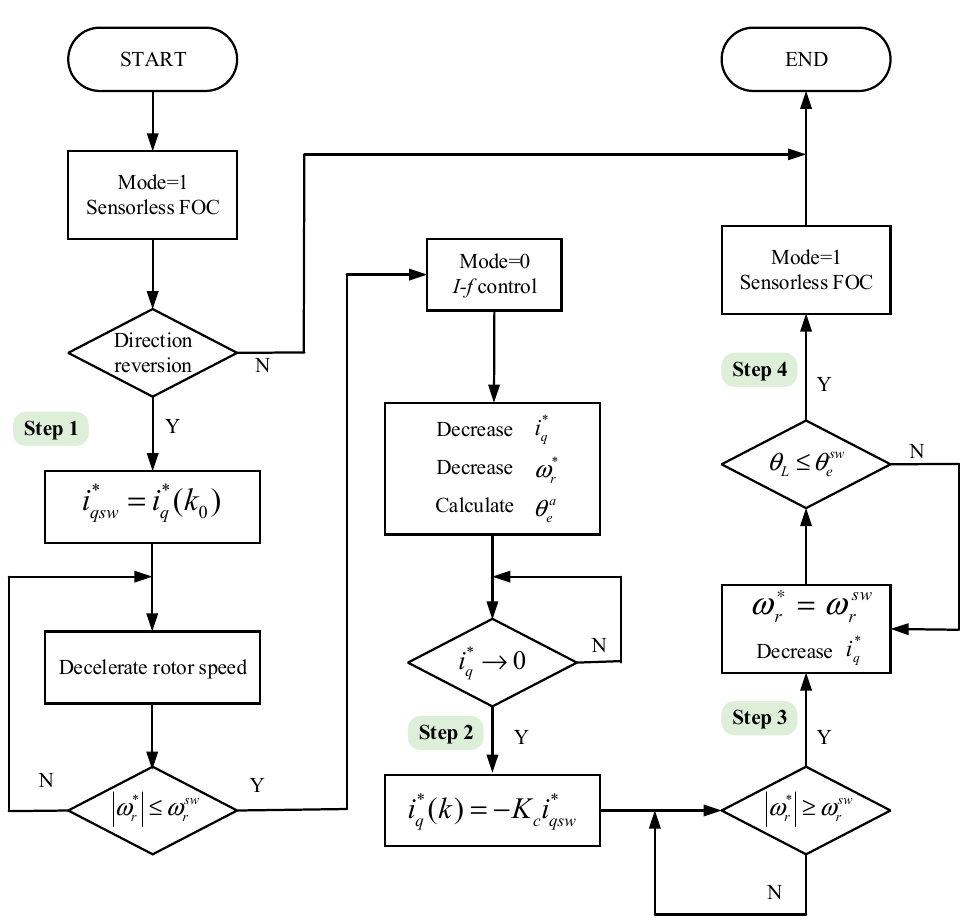
Figure 4. The I-f control strategy flowchart for the direction reversion transition.